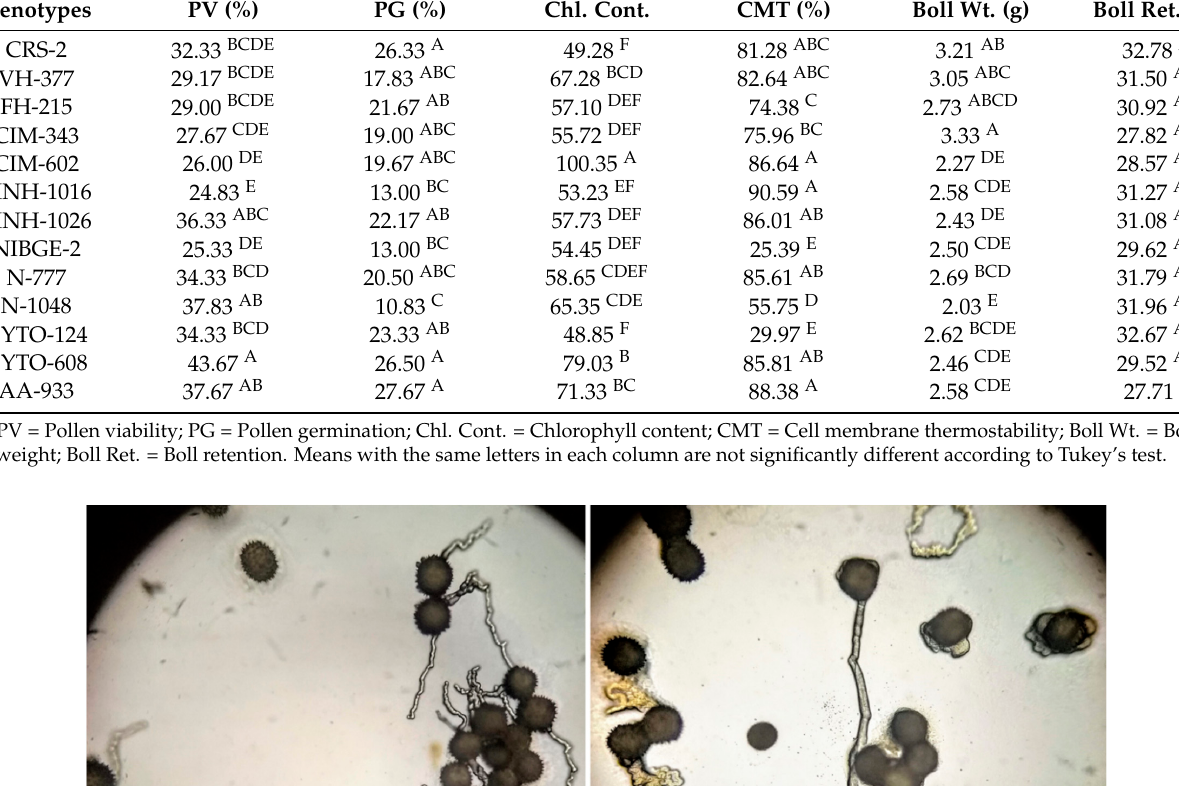
Figure 4. Results from staining pollen with triphenyl-tetrazolium chloride (TTC). ( a ) Pollen from flowers from the bottom positions of CYTO-608 shows the highest pollen viability. ( b ) Pollen from flowers from the top positions of NIBGE-2 shows the lowest pollen viability. Table 5. Mean values for six measures of heat tolerance in 13 cotton genotypes grown in 2019 in Faisalabad, Pakistan. Genotypes